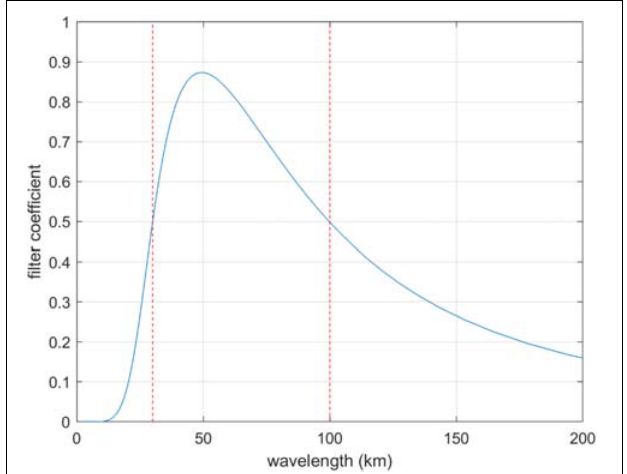
FIGURE 4 | The filter with pass-band (30–100)